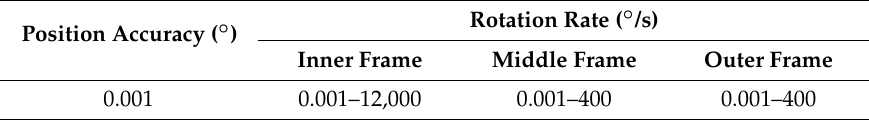
Table 2. Technical parameters of the tri-axial flight simulator.